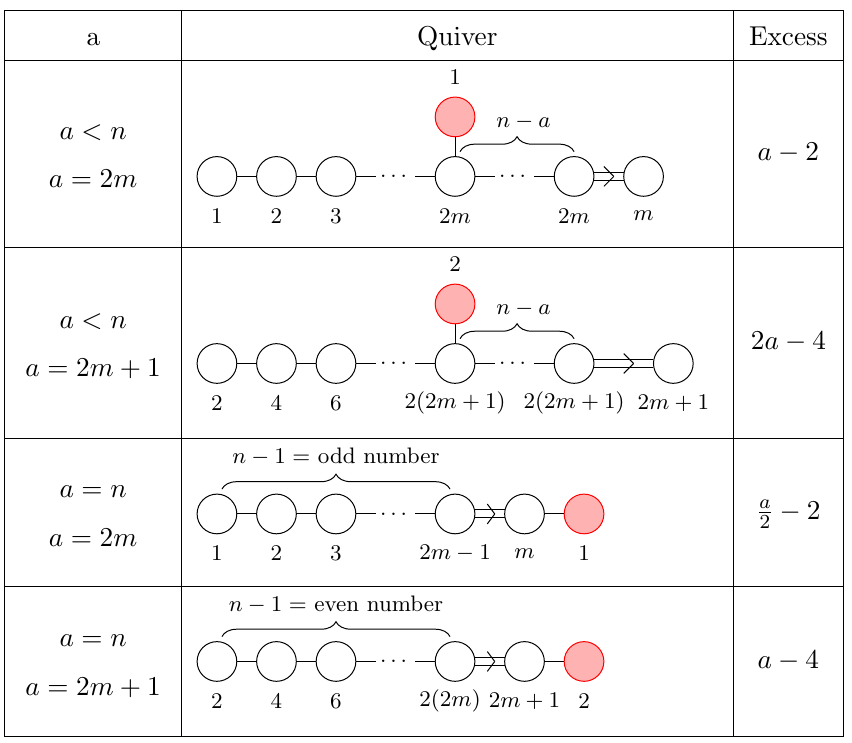
Table 8 . Classi(cid:12)cation of minimally unbalanced quivers with G = SO(2 n + 1).